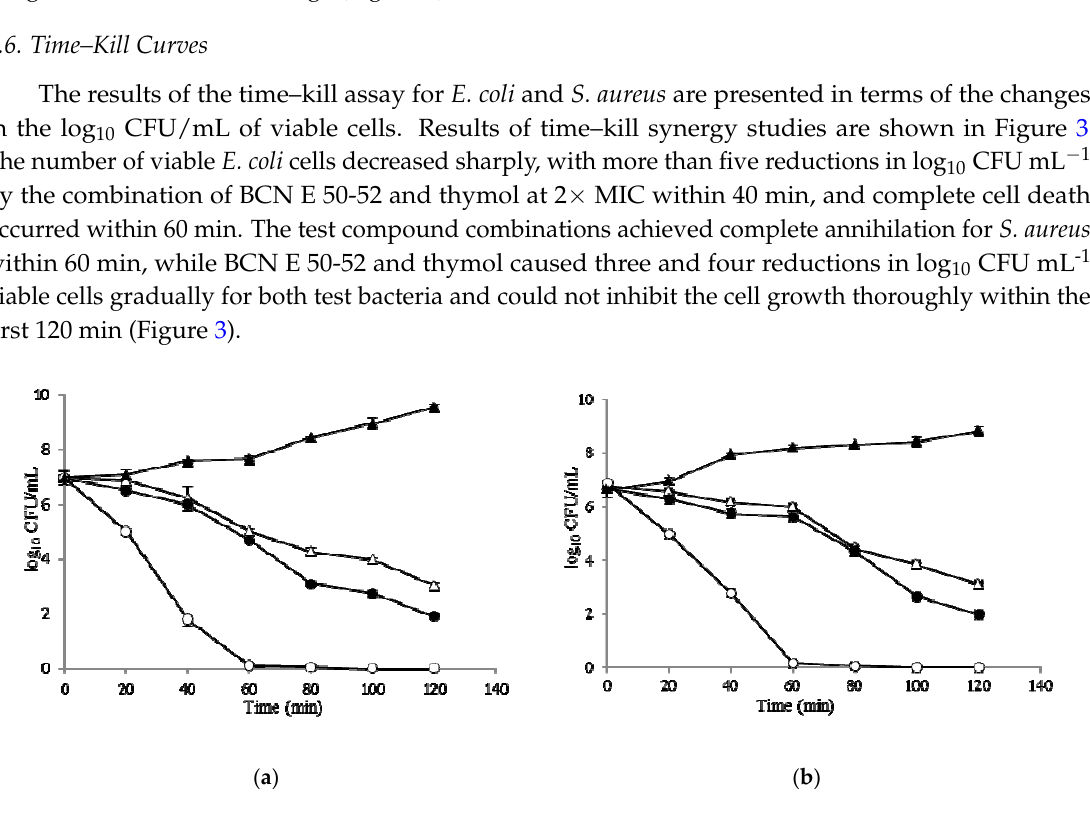
( b ) Figure 4. Bacterial growth kinetics of BCN E 50-52 and thymol at 2× MIC against E. coli and S. aureus . ( a ) E. coli; control (filled triangles), BCN E 50-52 512 µg/mL (filled circles), thymol 256 µg/mL (open triangles), BCN E 50-52 512 µg/mL and thymol 256 µg/mL (open circles); ( b ) S. aureus ; control (filled triangles), BCN E 50-52 512 µg/mL (filled circles), thymol 256 µg/mL (open triangles), BCN E 50-52 512 µg/mL and thymol 256 µg/mL (open circles). OD: optical density. 2.8. SEM Microscopy E. coli cells treated with a combination of thymol and BCN E 50-52 at FIC values illustrated complete cell deformation and cell wall destruction after 2 h (Figure 4b). Indicating similar symptoms, membrane piercing and subsequent cytoplasmic material leakage were obvious morphological changes of S. aureus cells after treating for 2 h with thymol and BCN E 50-52 at FIC values (Figure 4d). These results confirm rapid antimicrobial activities of BCN E 50-52 in combination with thymol and validate the time–kill and growth curve results.